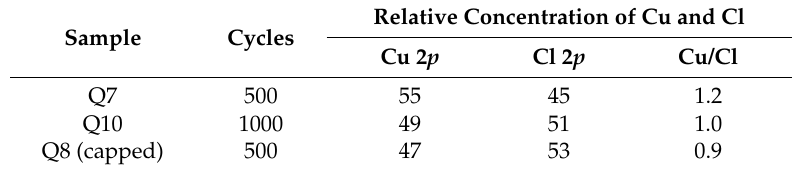
Table 3. Relative concentrations of Cu and Cl obtained from XPS (after Ar sputtering).